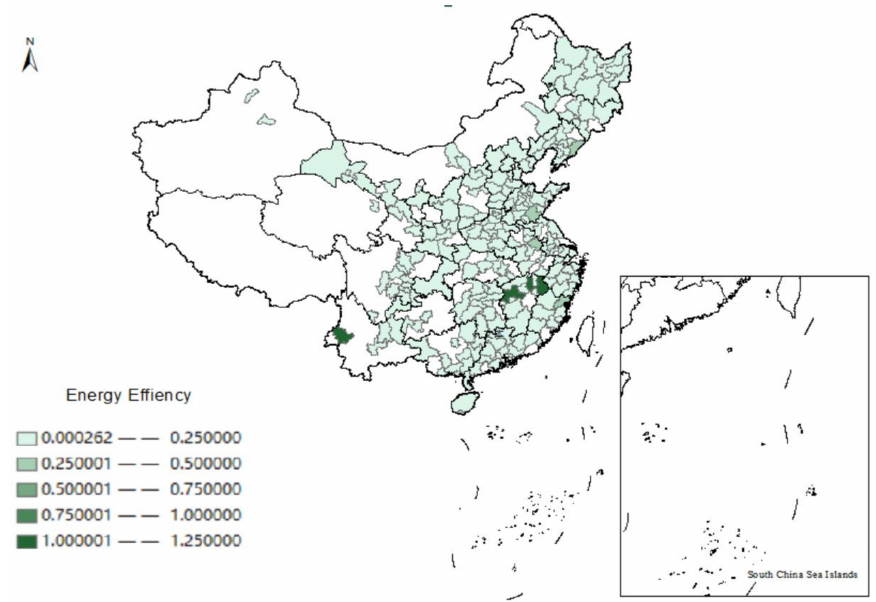
Figure 1. Spatial distribution of energy efficiency in China in 2000.